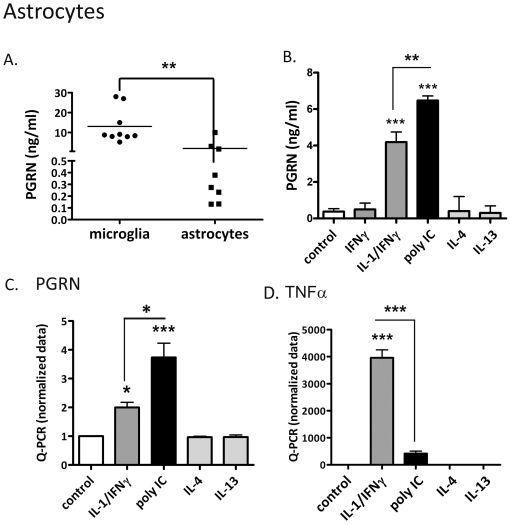
Proinflammatory stimuli enhance astrocyte PGRN Expression.Astrocyte cultures were treated with IFNγ ± IL-1, poly IC, IL-4, IL-13 or medium alone (control) and PGRN expression was examined by ELISA and Q-PCR. (A) Secreted PGRN levels in control microglia and astrocyte cultures determined by ELISA (24 h) show that microglia produce larger amounts of PGRN than astrocytes. Each symbol represents a different case. (B) Representative ELISA data from cytokine-stimulated astrocyte cultures (24 h stimulation). (C, D) Pooled normalized Q-PCR data for PGRN and TNFα from astrocyte cultures (6 h stimulation, n = 5) are shown. Data are mean ± SD. * p<0.05, ** p<0.01, *** p<0.001. The results show that proinflammatory stimuli induce astrocyte PGRN production.